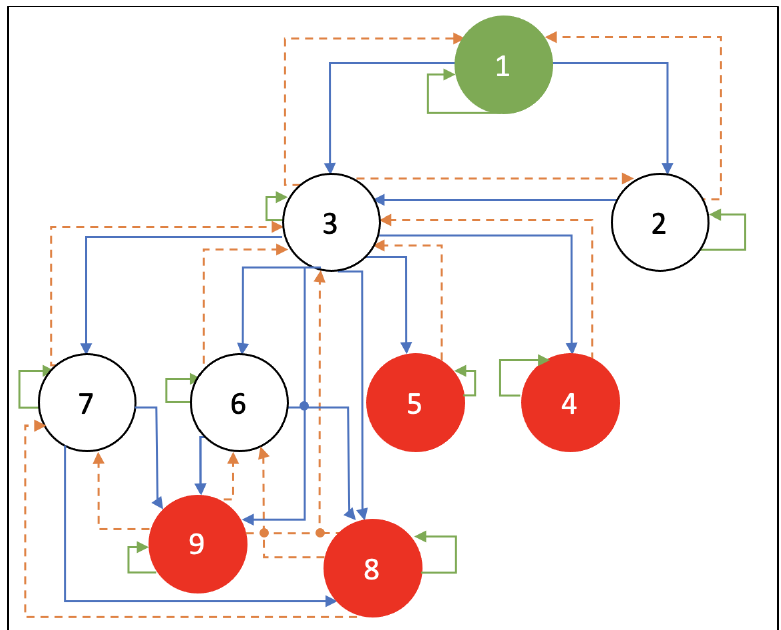
Figure 3. Rewards-augmented attack graph.